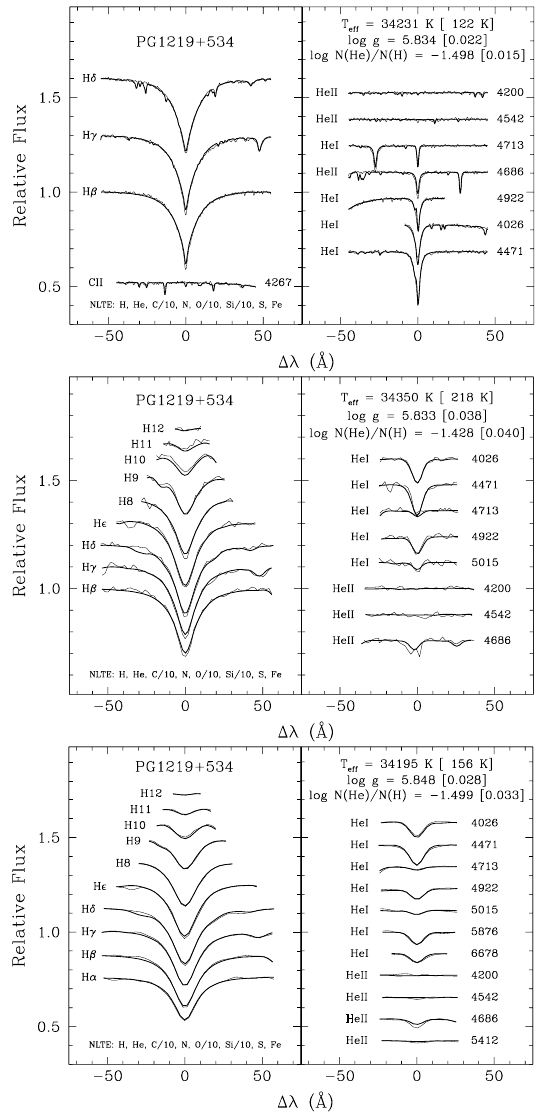
Figure 1. Top panel: Model fit (solid curves) to all the hydrogen and helium lines available in our moderately high S/N, 1A reso- lution MMT optical spectra of PG 1219+534. The fit was done us- ing a three-dimensional grid of NLTE synthetic spectra ( T eff , log g , log N (He)/ N (H) in which the abundances of C, N, O, S, Si, and Fe were fixed at amounts consistent with Blanchette et al. (2008). Mid- dle panel: Same, but for our high S/N 6A resolution Bok telescope spectra. Low panel: Same, but for high S/N 9A resolution Bok tele- scope